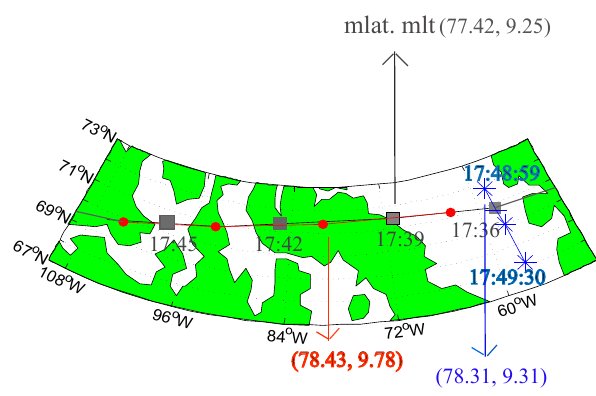
Figure 2. Projection of satellite footprints to 120km altitude in ge- ographical coordinates for 24 June 2009: red dots are for Cluster 4, grey squares are for Cluster 3, blue stars are for CHAMP. Times in blue are for the CHAMP, while grey times are for Cluster 3. Arrows point to magnetic latitude and magnetic local time for satellites in conjunction.